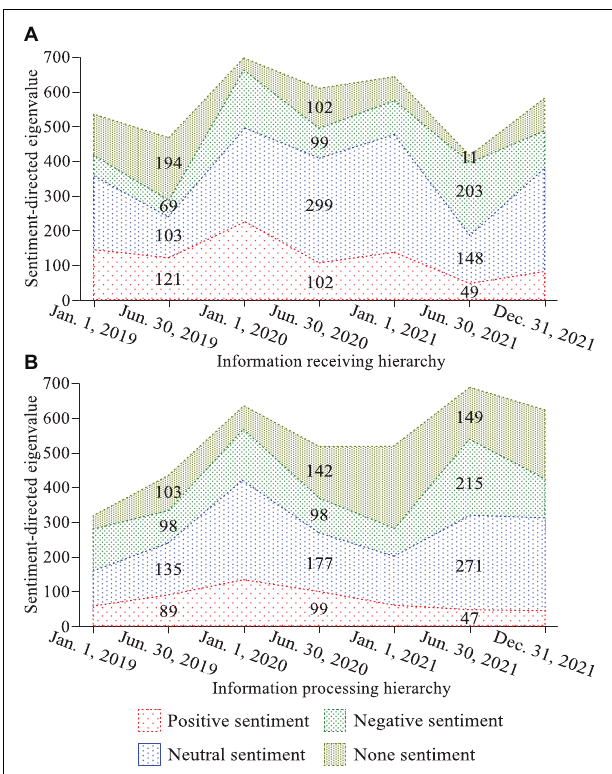
FIGURE 5 | Sentiment statistics and dimension analysis of information receiving (A) and processing (B) in the quantitative model of laptop brand recognition based on sentiment analysis of big